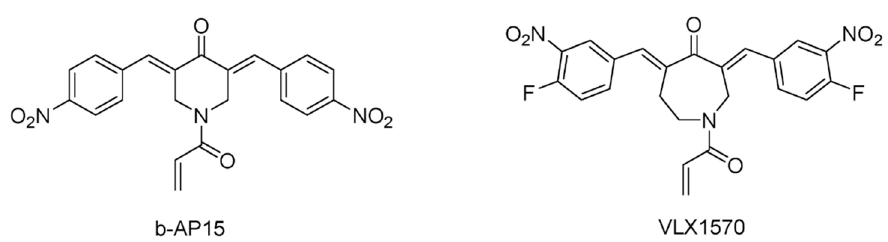
Figure 4. Structures of reported USP inhibitors in clinical trials.